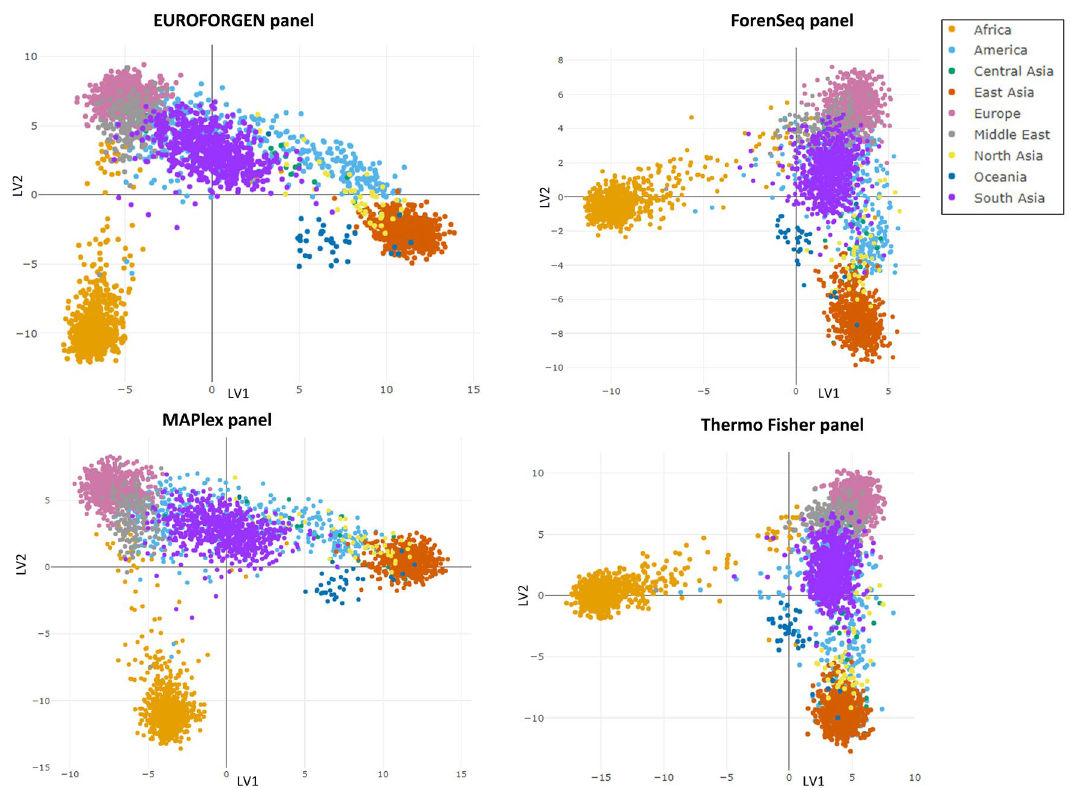
Figure 2. PLS-DA Scores plots showing the models obtained for the different evaluated AIMs